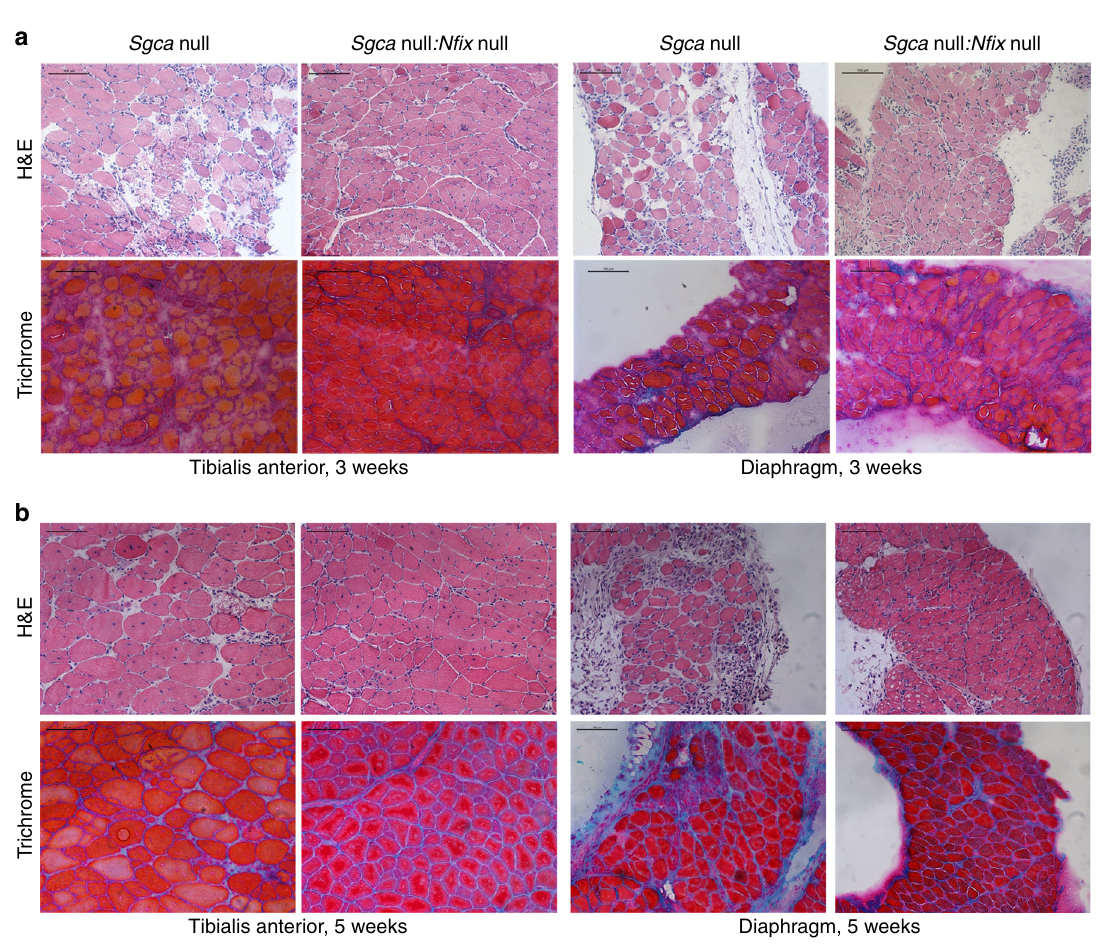
Fig. 1 Lack of N fi x improves signs of muscular dystrophy. a Hematoxylin and eosin (H&E) and Milligan ’ s trichrome staining of tibialis anterior (left) and diaphragm (right) muscles at 3 weeks of age; N = 12 Sgca null and 6 Sgca null: N fi x null mice. Scale bar 100 μ m. b Hematoxylin and eosin (H&E) and Milligan ’ s trichrome staining of tibialis anterior (left) and diaphragm (right) muscles at 5 weeks of age; N = 5 Sgca null and 5 Sgca null: N fi x null mice. Scale bar 100 μ m. See also Supplementary Fig. 1 for the analysis of central nucleation in tibialis anterior and diaphragm muscles at 3 and 5 weeks NATURE COMMUNICATIONS | 8: